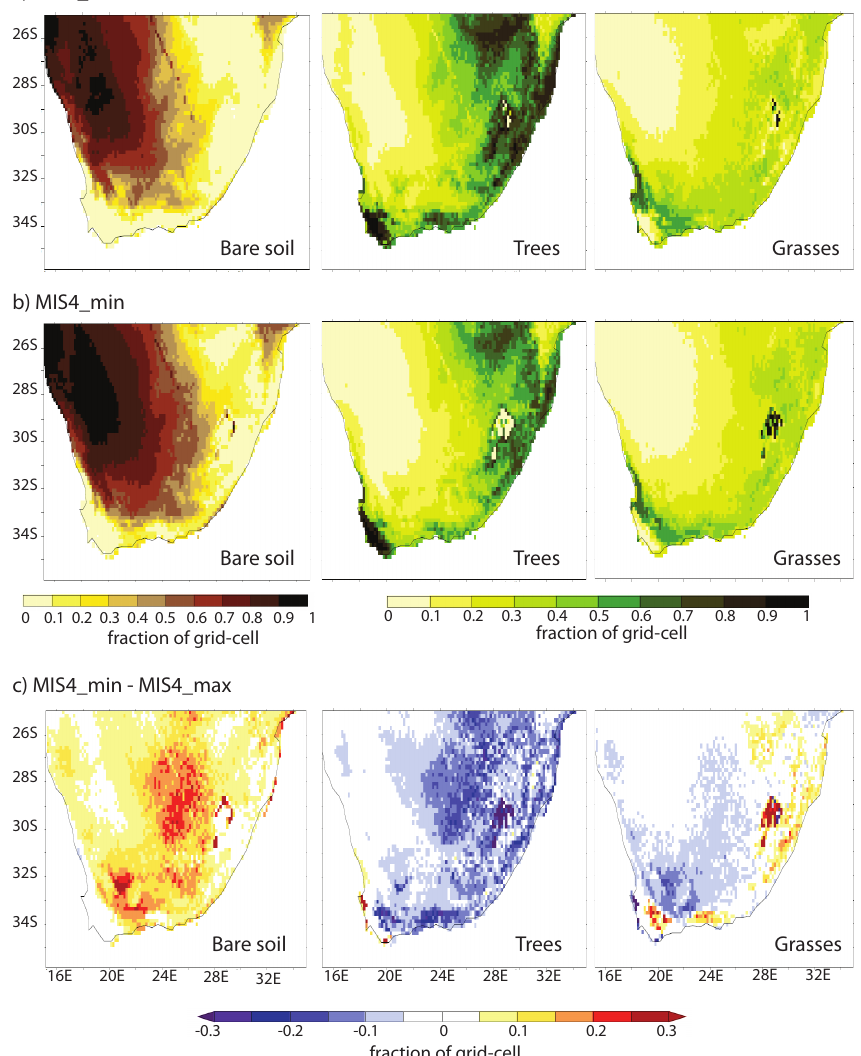
Figure 10. Vegetation cover (fraction of grid cell) simulated with LPJ-LMfire forced off-line. (a) MIS4_max, (b) MIS4_min, and (c)